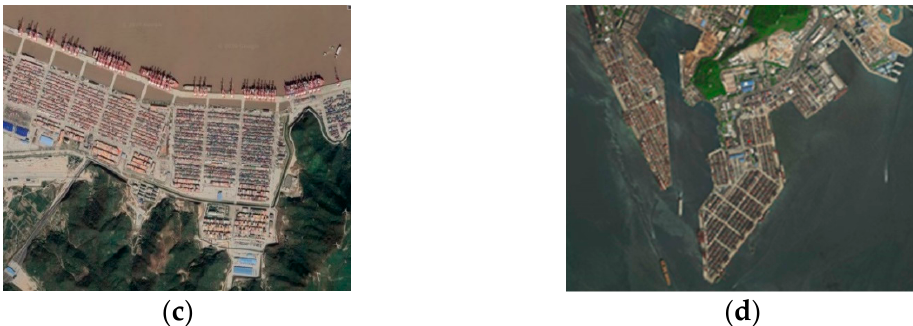
Figure 5. Satellite map of the port. ( a ) Yantian Port; ( b ) Yangshan Port; ( c ) Ningbo Port; ( d ) Shenzhen Port.